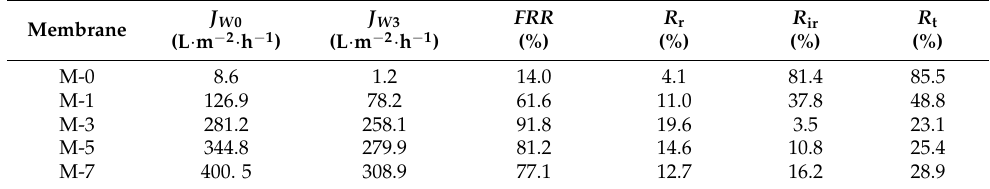
Table 2. Antifouling properties of pristine blend membrane and modified membranes.